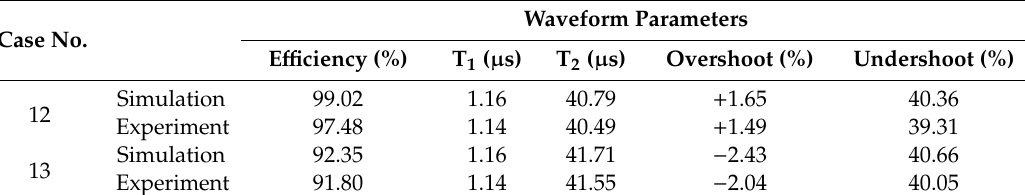
Table 9. Circuit and waveform parameters of the generated waveforms in the example cases. Case No.